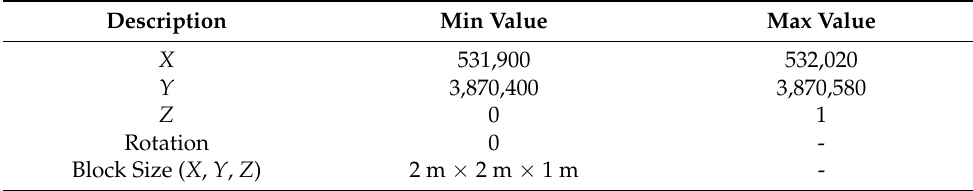
Table 3. Block model geometrical parameters.